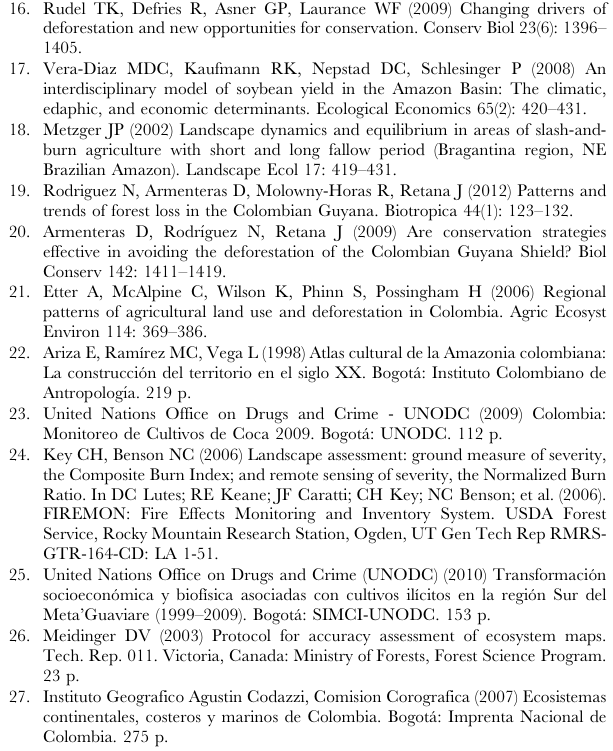
Table S1 Landsat images used in this